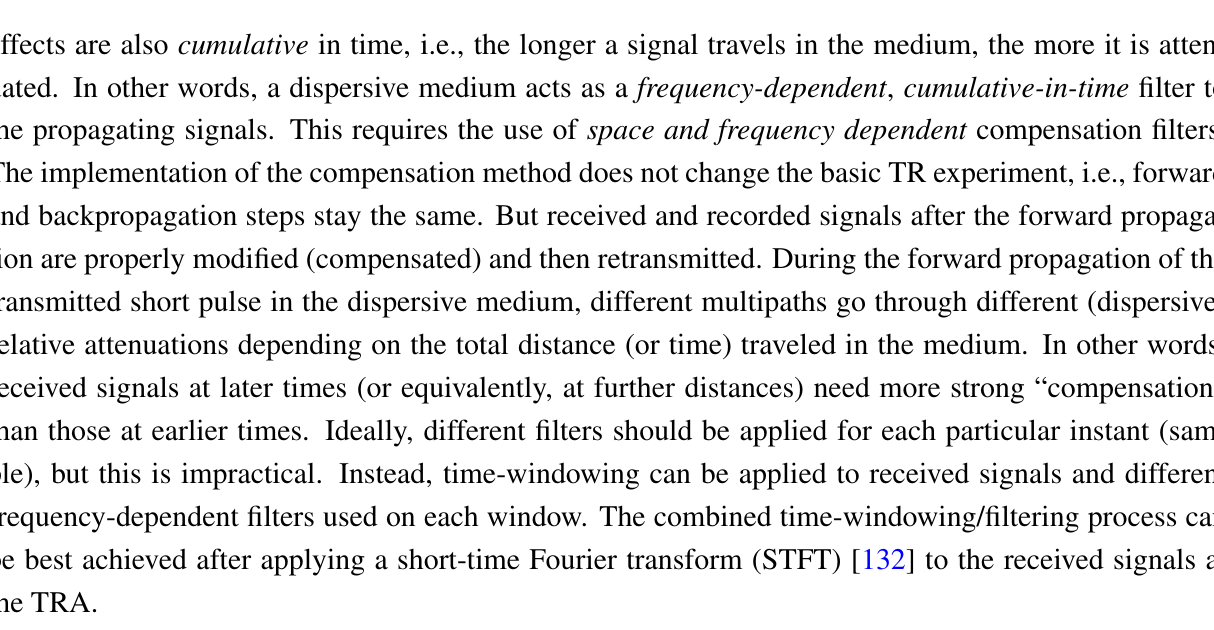
(cid:113) µ(cid:178) ( ω )¯ r ) plotted with respect to